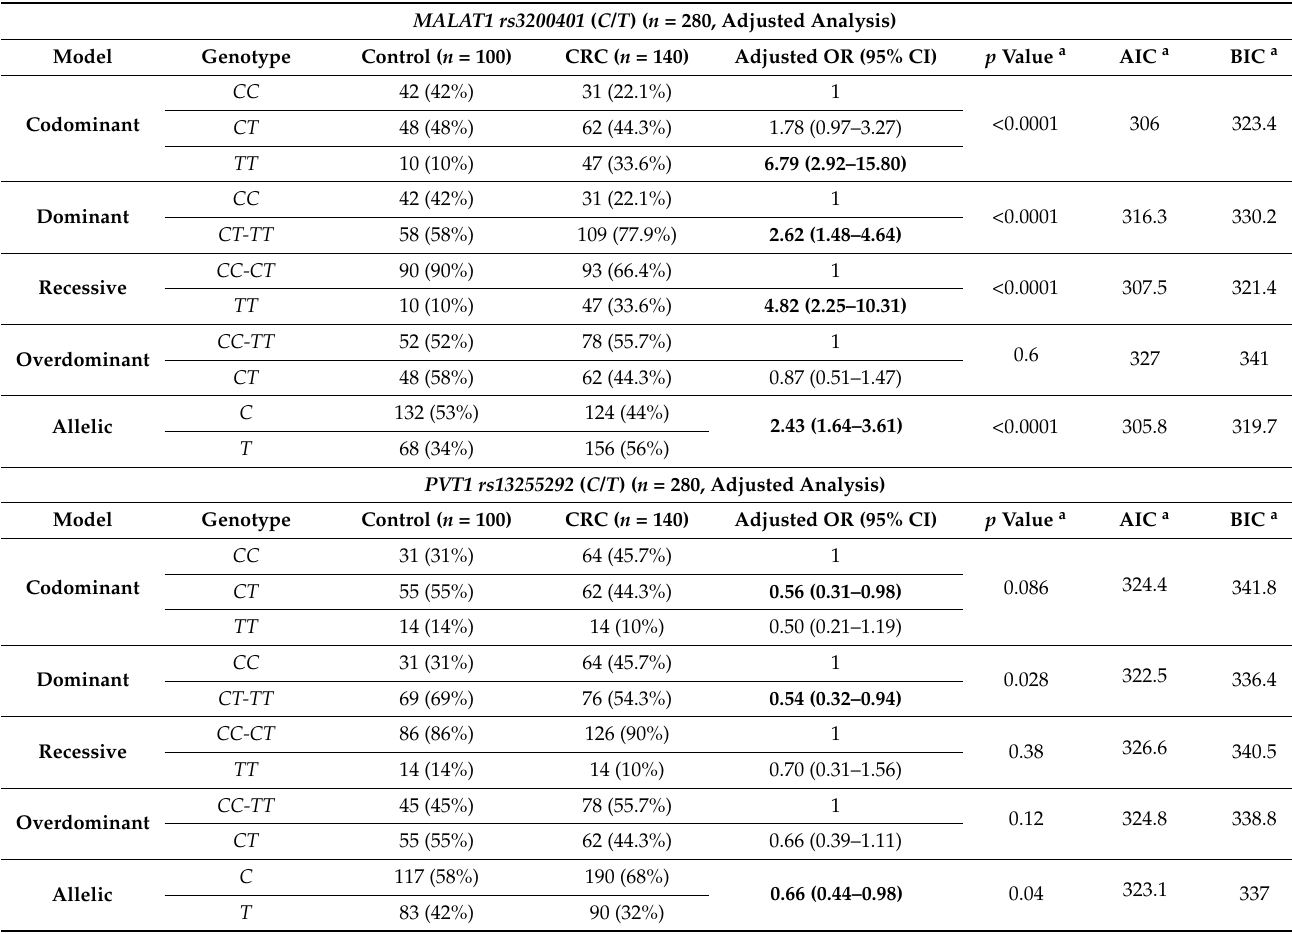
Table 2. Genotype and Allele Frequencies of MALAT1 rs3200401 ( C/T ) and PVT1 rs13255292 ( C/T ) in CRC and Healthy